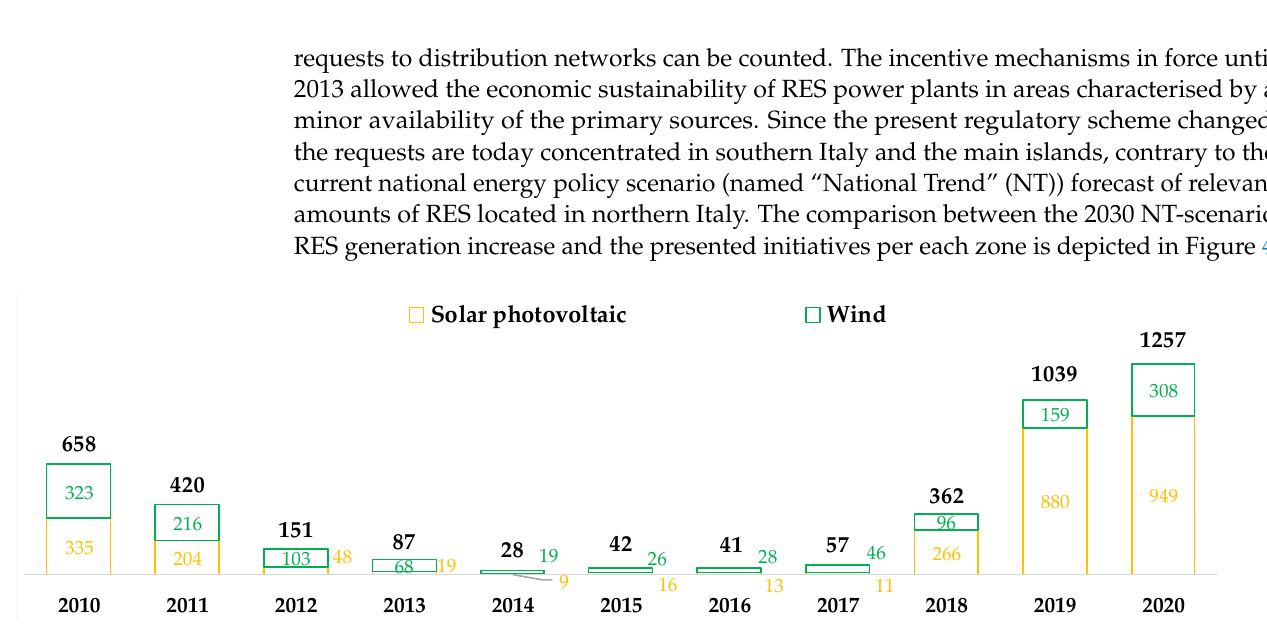
Figure 3. Number of new solar photovoltaic and wind connection requests evolution in Italy, Decem-